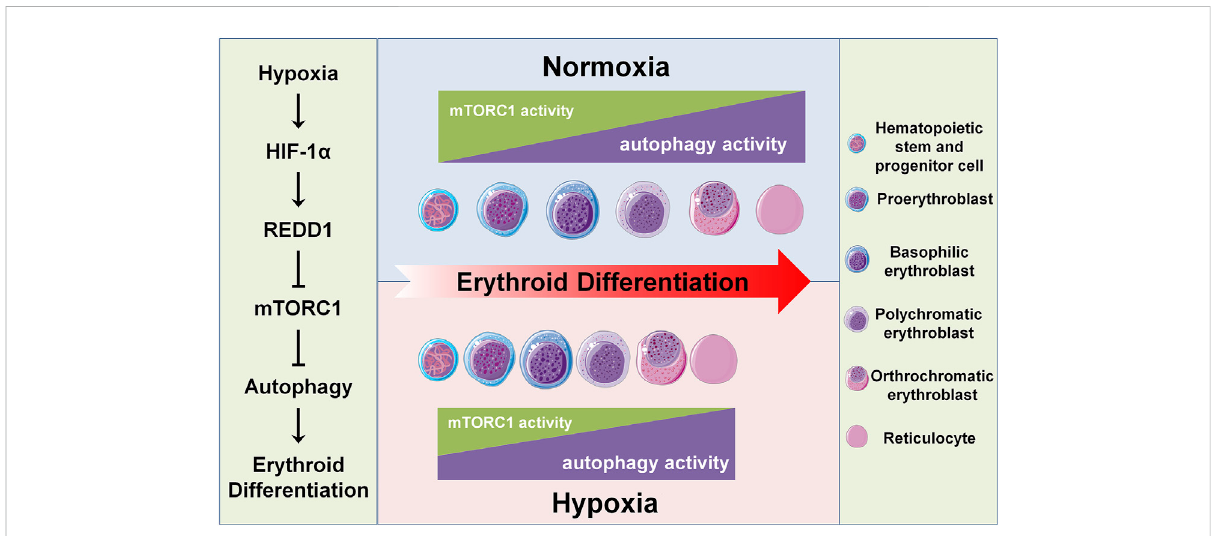
FIGURE 6 Schematic diagram of hypoxia accelerating erythroid differentiation in HSPCs. The left panel shows the underlying mechanism of hypoxia acceleratingerythroiddifferentiation.Underhypoxia,HIF-1asamastertranscriptionfactortranscriptionallyactivatesitstargetgeneREDD1,whichin turn inhibits mTORC1 activity, thereby promoting autophagy activity and hence accelerating erythroid differentiation. The central panel shows the patternoferythroiddifferentiationunderthecontrolofmTORC1andautophagyinnormoxiaandhypoxiaconditions.Undernormoxia,withthe process of erythroiddifferentiation, the activity of mTORC1 gradually decreases and the autophagy activity increases concomitantly; under hypoxia, these trends are enhanced, thus accelerating the erythroid differentiation. The right panel shows the